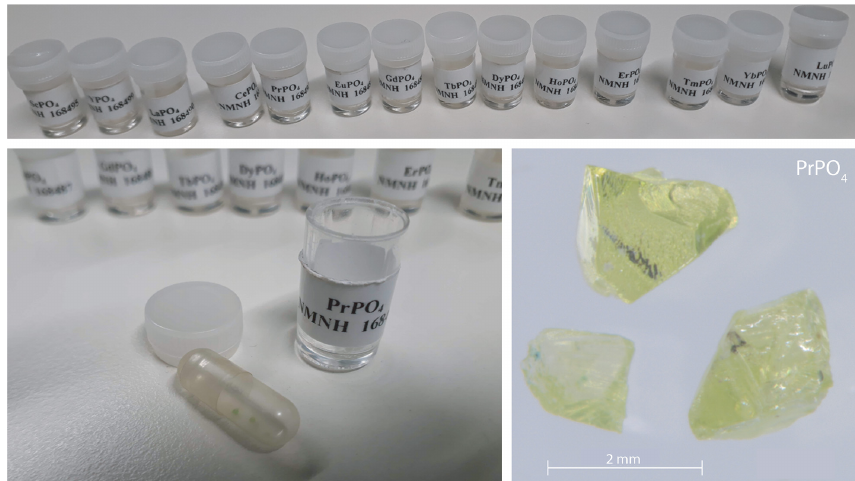
Figure 1. The reference REE orthophosphates from the National Museum of Natural History (example PrPO 4 ).